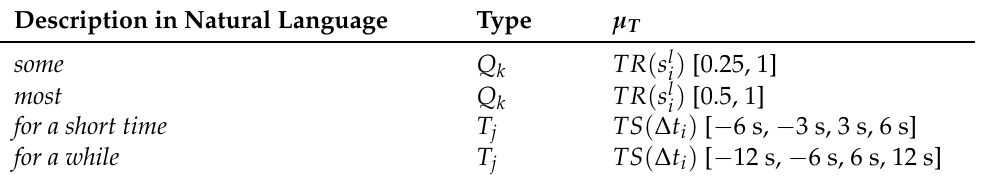
Table 6. Membership functions for FTWs and quantifiers defined for the protoform V r T j Q k .